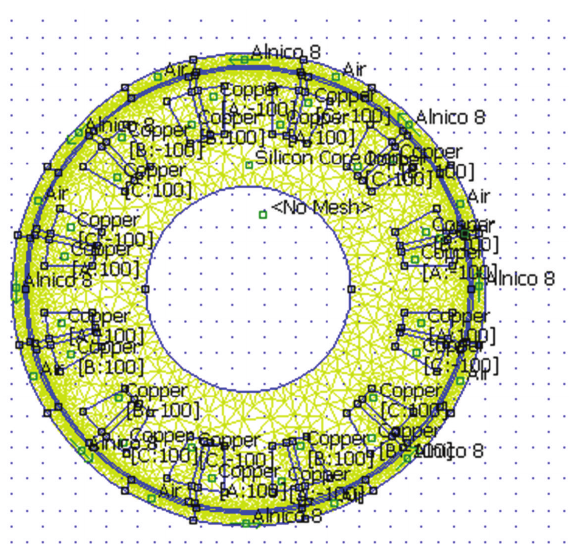
Figure 2: Fem meshed 2D model.